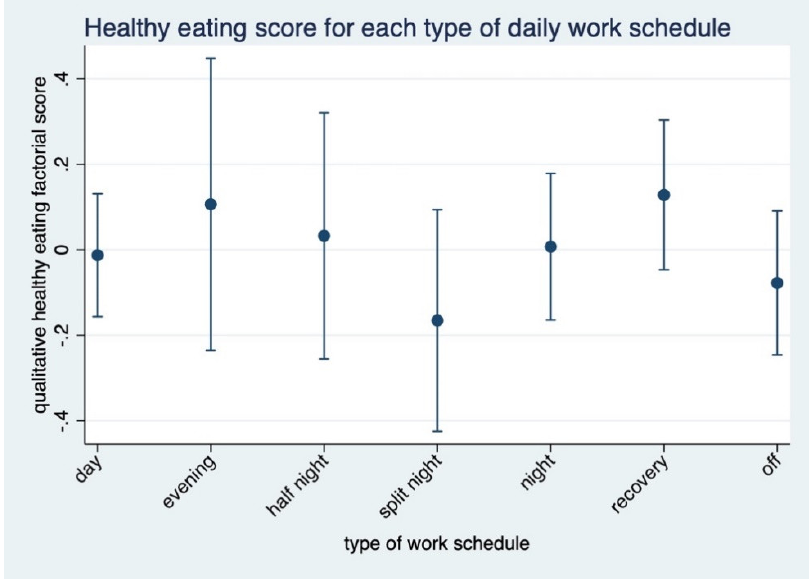
Figure 2. Daily qualitative healthy eating factorial score normalizing for total energy intake (positive score meaning healthier) for each schedule type.